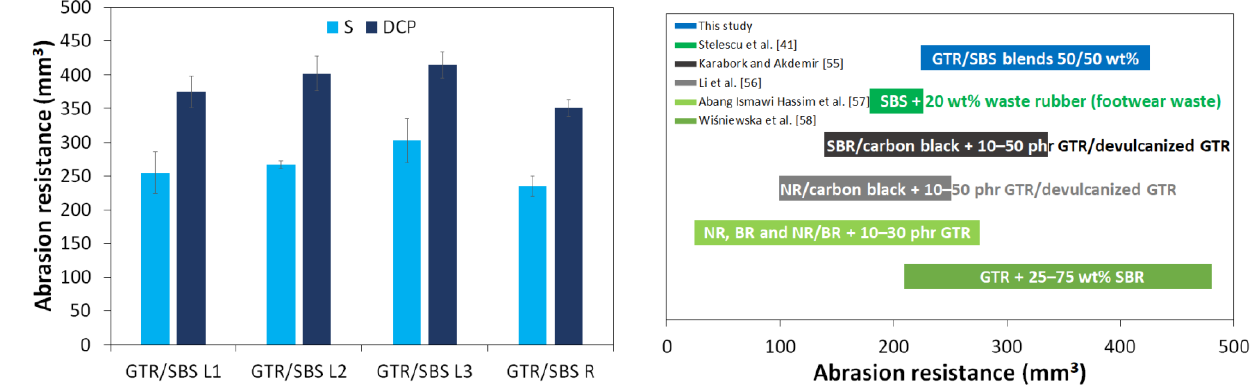
Figure 4. Abrasion resistance of GTR/SBS blends, and the comparison with the literature data Figure 4. [41,55 – 58].